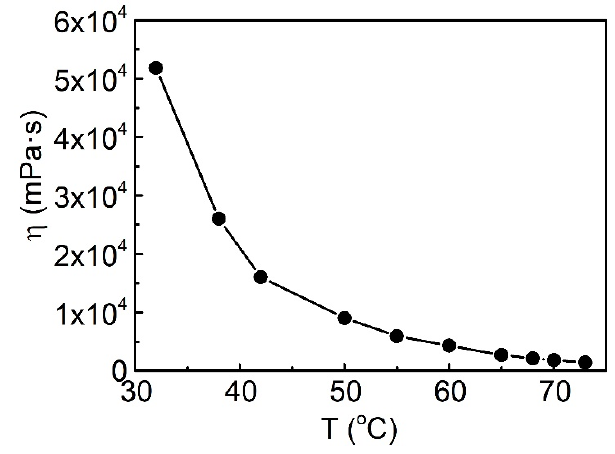
Figure 1. Viscosity–temperature plot of heavy oil from the Shengli oil field.